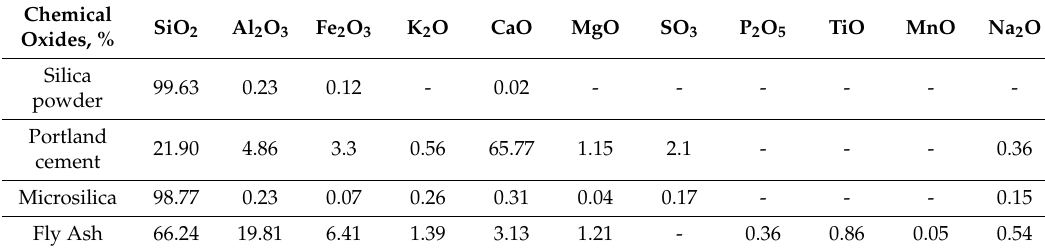
Table 3. Chemical compositions of silica flour, Portland cement, microsilica and fly ash in percentages (%).